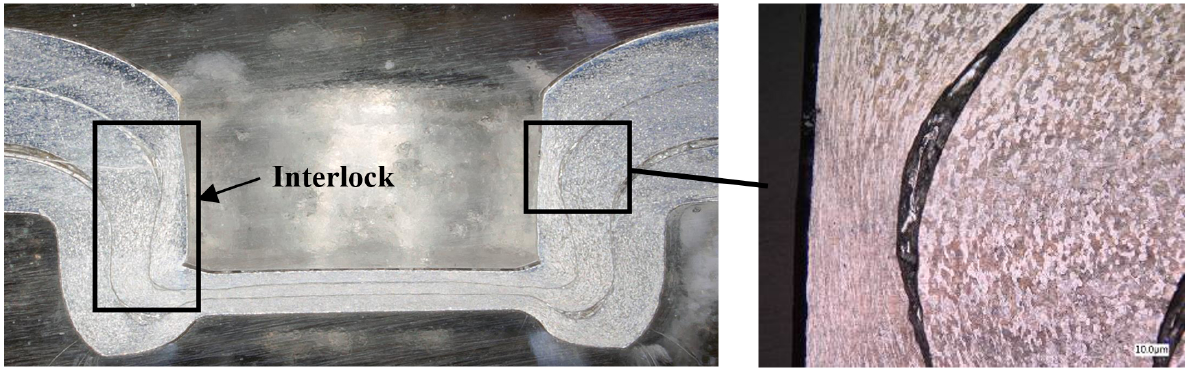
Figure 11: Areas of interlocking of clinched joints with DC06 steel sheet.